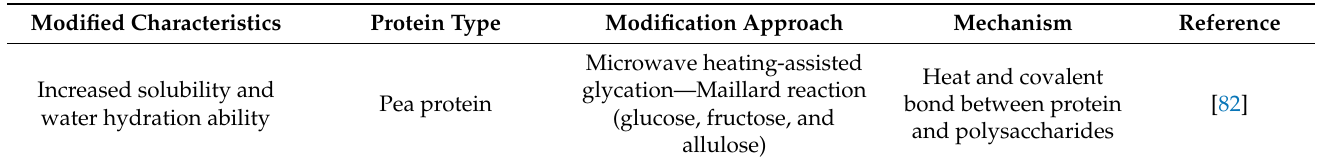
Table 1. A summary of recent studies evaluating the effects of modification approaches on plant-based protein